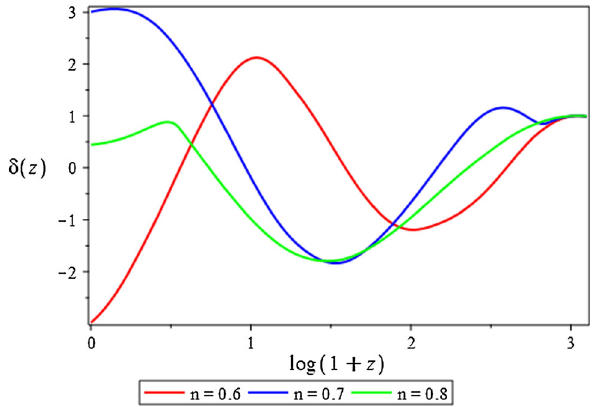
Fig. 15 δ( z ) versus z in long-wavelength mode for Eq. (115) for the values of 0 . 6 ≤ n < 0 .